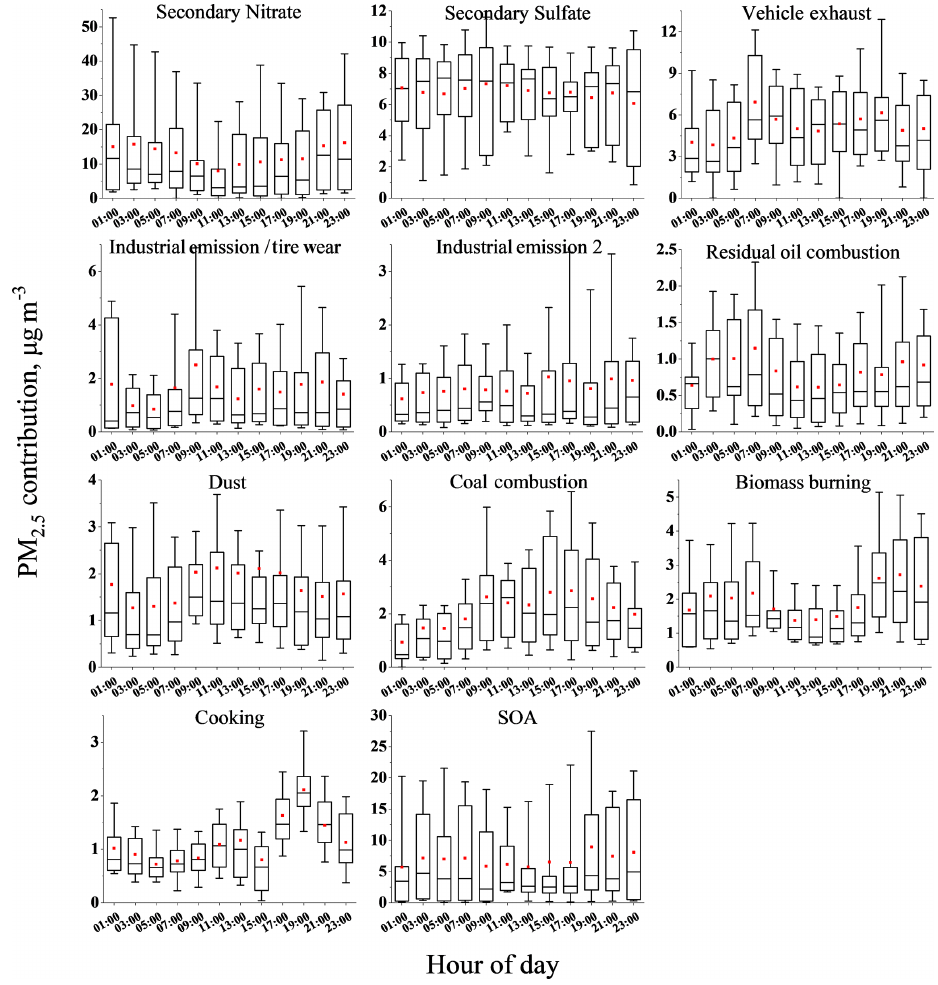
Figure 4. Diurnal variation in individual source factors resolved by MM-PMF (25th and 75th percentile boxes, 10th and 90th percentile whiskers; lines inside the boxes represent the hourly median, and the red points represent the hourly mean).